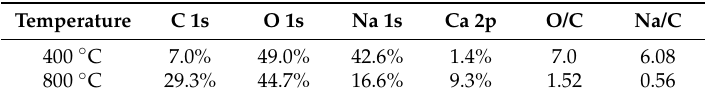
Table 2. Composition and ratios of surface elements of NaOH/shell.